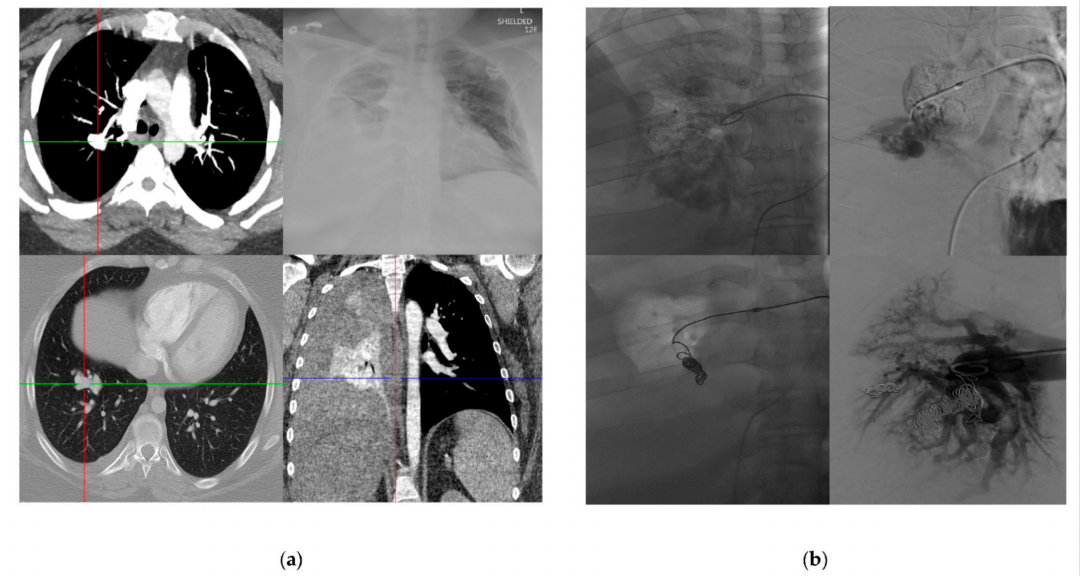
Figure 3. A 40-year-old female with HHT who presented with hemoptysis. ( a ) CXR showing large left-sided hemothorax, confirmed on CT, causing collapse of the adjacent lung. ( b ) Pulmonary angiography demonstrating a complex RLL AVM, followed by coil embolization and resolution of